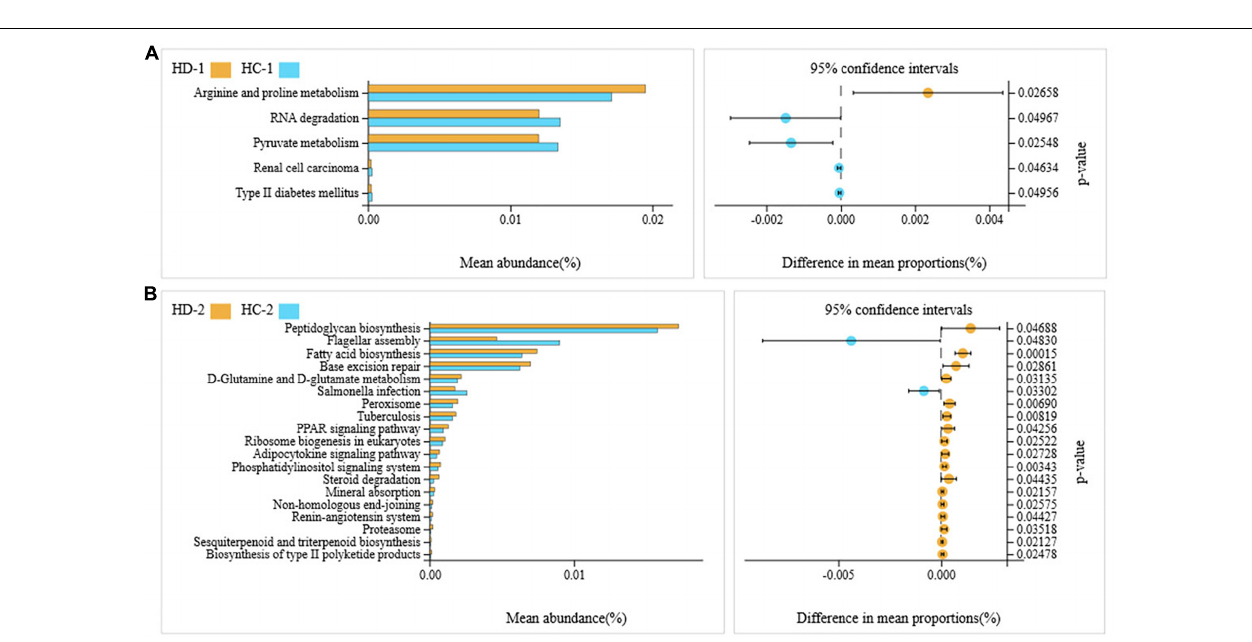
FIGURE 5 | KEGG pathways for bacteria in ileal meconium of neonatal piglets before suckling. HD-1: bacteria of ileal meconium of Hoxa1 − / − neonatal piglets from the control group. HD-2: bacteria of ileal meconium of non-Hoxa1 − / − neonatal piglets from the control group. HC − 1: bacteria of ileal meconium of Hoxa1 − / − neonatal piglets from the experimental group. HC-2: bacteria of ileal meconium of non-Hoxa1 − / − neonatal piglets from the experimental group. (A) Control group. (B) Experimental group.